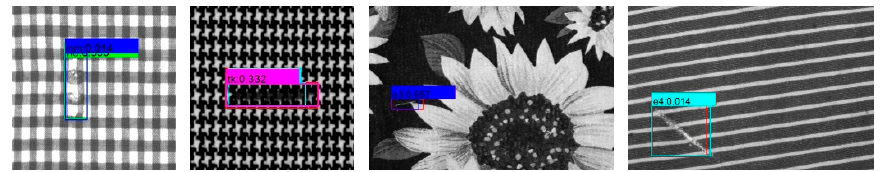
Figure 16. Some examples of false detected images in the experimental results.